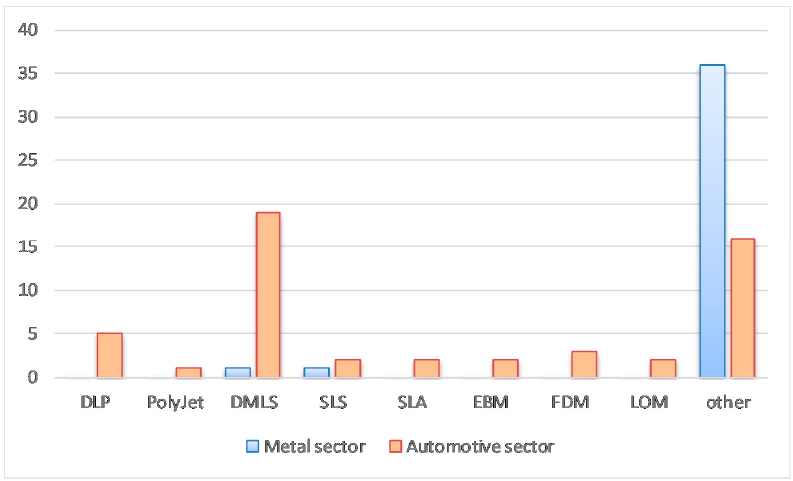
Figure 2. Interest in implementing AM in the manufacturing companies surveyed in the metaland automotive industries.